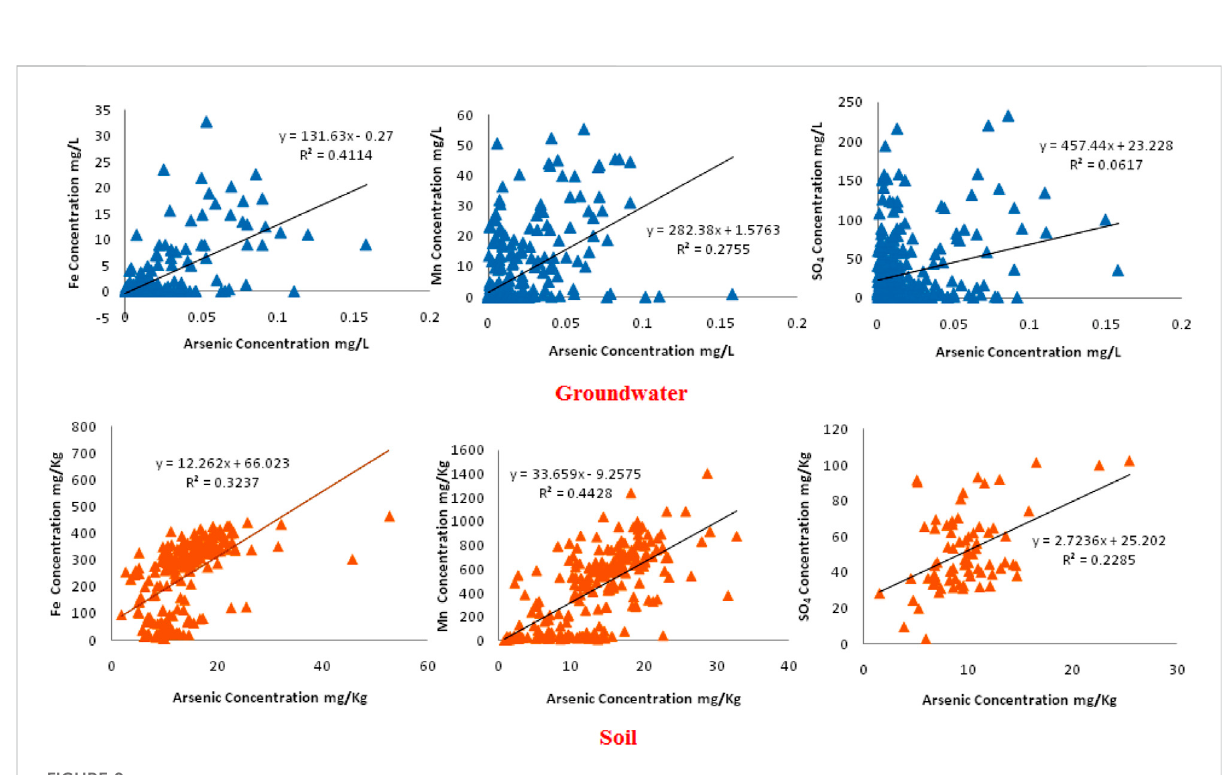
FIGURE 9 Arsenic correlations with elements in the GW and